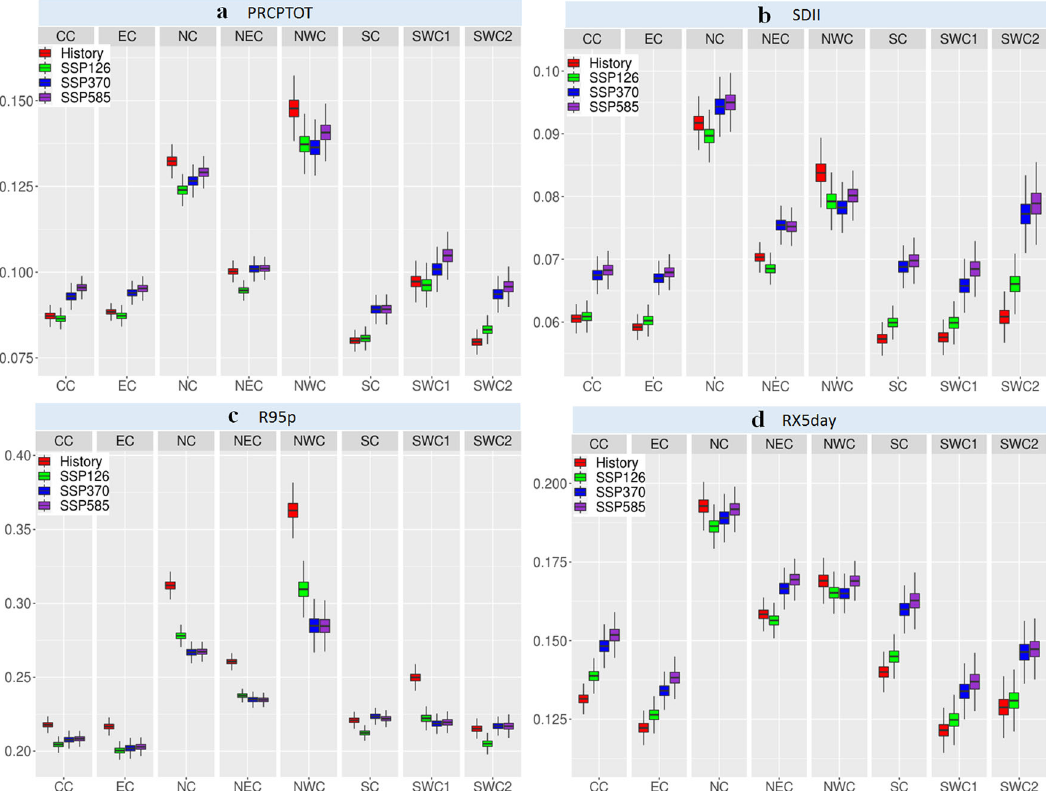
Fig. 6 Boxplots of the resampled averaged Gini-coef fi cients in eight regions. Boxplots for a PRCPTOT, b SDII, c R95p, and d RX5day for eight regions in China for CMIP6 for historical simulations (1961 – 2005) and future simulations (SSP126, SSP370, and SSP585, from 2051 to 2095) obtained by the bootstrapping procedure. The sub fi gures were done in the software R 4.0.2 (https://cran.r-project.org/bin/windows/), and then the sub fi gures were merged by using the Microsoft PowerPoint 2013 software